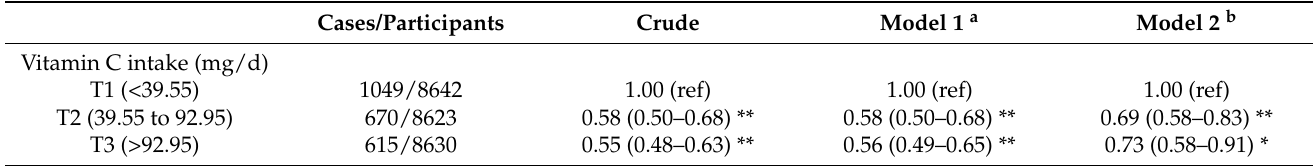
Table 2. Weighted ORs and 95% CIs for depressive symptoms according to terciles of dietary vitamin C